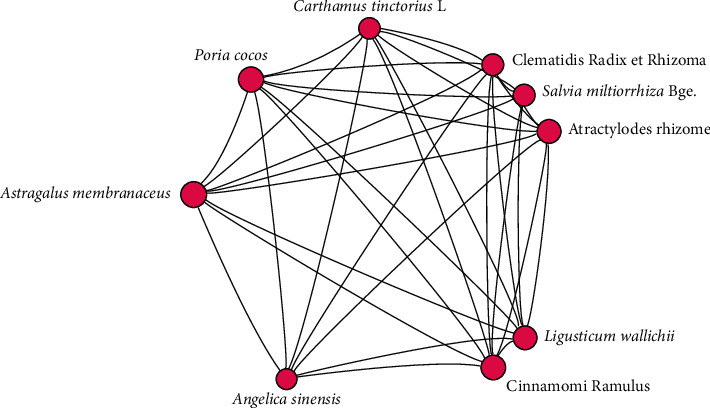
Core prescriptions.